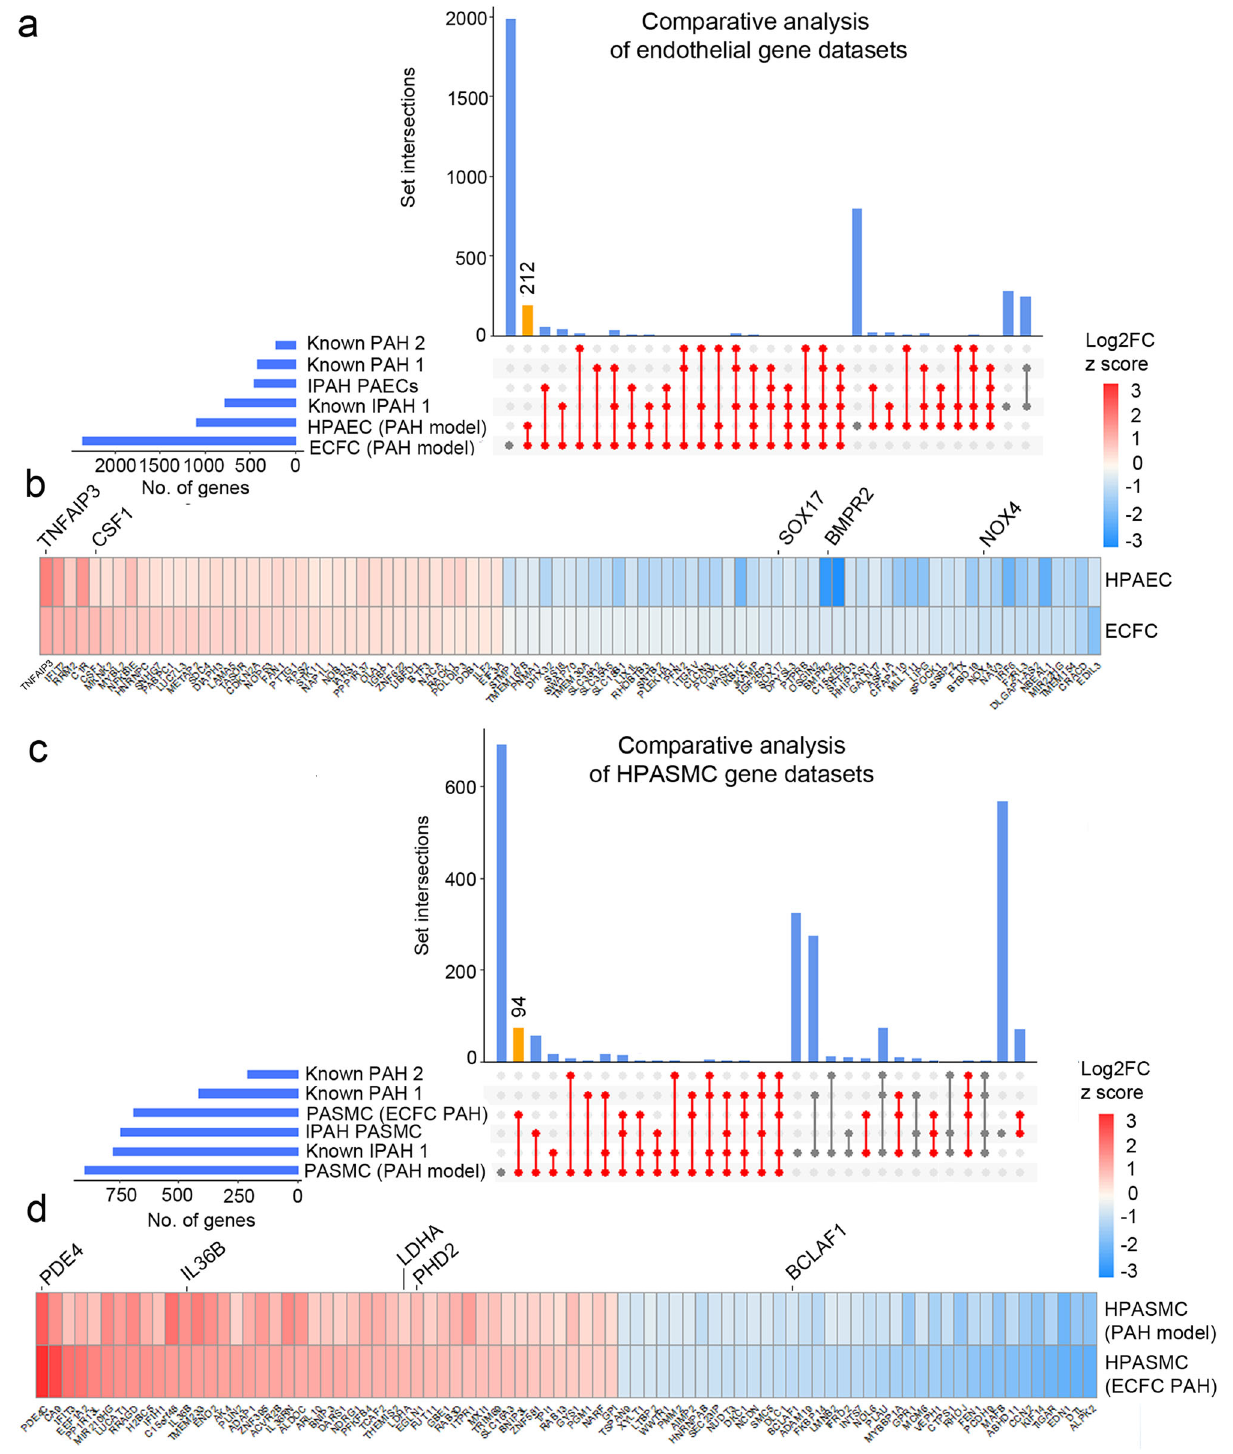
Fig. 6 Comparative analysis of micro fl uidic PAH models and published PAH and IPAH gene datasets. DEG datasets from the adenoviral two-hit models (PAH Model) and patient ECFC models (ECFC PAH) of PAH were compared against previously reported RNAseq studies and lists of genes known to be associated with PAH and IPAH. UpSet plots and heatmaps detail comparative analysis of a , b endothelial gene datasets and c , d smooth muscle cell datasets. In a , c the largest gene overlaps are highlighted in yellow. Heatmaps in b , d visualise the similarity of gene expression changes between the two micro fl uidic models of PAH, the two-hit PAH model and the ECFC PAH model; downregulated genes are in blue and upregulated genes are in red. RNAseq datasets used for comparative analysis were from PASMCs from IPAH lung transplants 22 (database named here IPAH PASMCs); PAECs isolated from IPAH lung transplants 23 (namedhereIPAH PAEC).Othercomparativegene sets includedgeneswithknown PAH-associations 24 (here named “ knownPAH2 ” ) and the DisGENET public database https://www.disgenet.org/search, where following gene sets were obtained: DisGENET PAH (https://www.disgenet.org/browser/0/1/0/ C2973725/), (here named “ known PAH1 ” ); DisGENET IPAH (https://www.disgenet.org/browser/0/1/0/C3203102/) (here named “ known IPAH1 ”